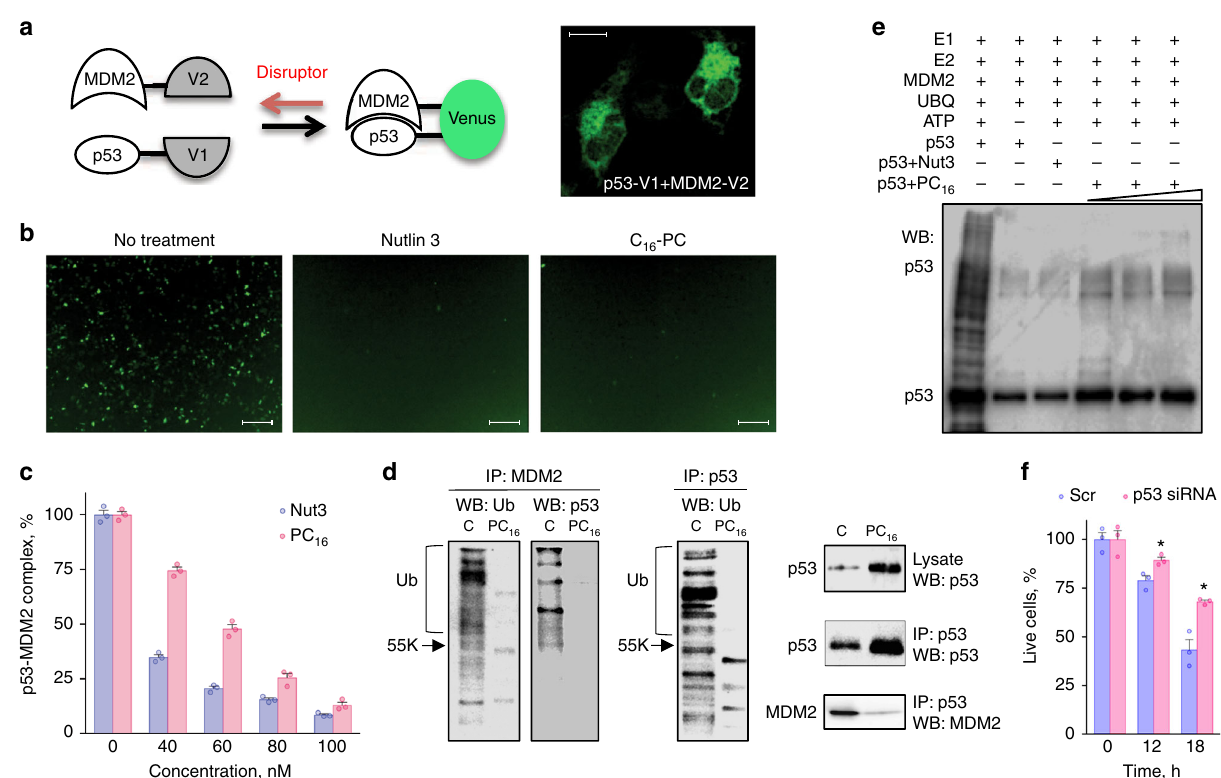
Fig. 4 C 16 -pyridinium ceramide is a disruptor of the p53 – MDM2 complex. a Schematic of the approach to visualize p53 – MDM2 complex in the cell; each of the proteins is expressed as a fusion with a half of yellow fl uorescence protein Venus (V1 and V2, correspondingly); the formation of the complex between p53 and MDM2 reconstitutes Venus (seen in the confocal image of PC-3 cells, scale bar represents 20 μ m; see also Supplementary Figures 5 & 6). b Fluorescent microscopy of untreated and Nutlin 3 (50 µ M) or PC 16 (5 µ M) treated PC-3 cells co-expressing p53-V1 and MDM2-V2. Scale bar represents 200 μ m. c ELISA measurements of the p53 – MDM2 complex in the presence of increasing concentrations of either Nutlin 3 or PC 16 (mean± SE, n = 3; standard curve is presented in Supplementary Figure 4). d p53 does not co-immunoprecipitate with MDM2 (left panel) and loses ubiquitination (middle panel) in PC 16 -treated cells; right panel shows input. Reciprocally, MDM2 very weakly co-immunoprecipitates with p53 in PC 16 -treated cells (right panels). A549 cell lysates were used in these experiments. e In vitro ubiquitination assays of puri fi ed p53 alone and in the presence of Nutlin 3 (80 nM) or PC 16 (60, 80, and 100 nM). f siRNA silencing of p53 partially rescues A549 cancer cells from the PC 16 toxicity. Error bars represent ± SE, n = 3 (* P < 0.01, Student ’ s t test). A representative experiment (out of three) is